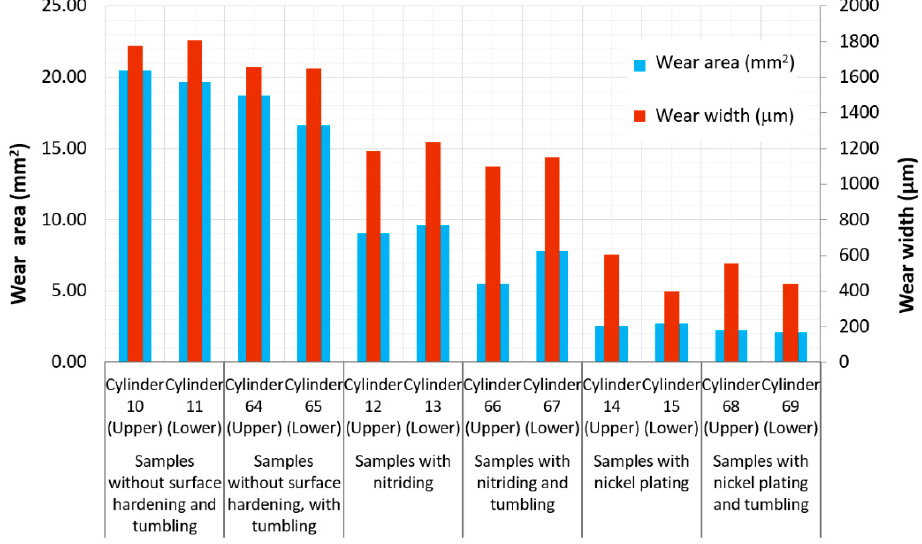
Figure 24. Frequency load (all samples of configuration Cylinder / Cylinder together).